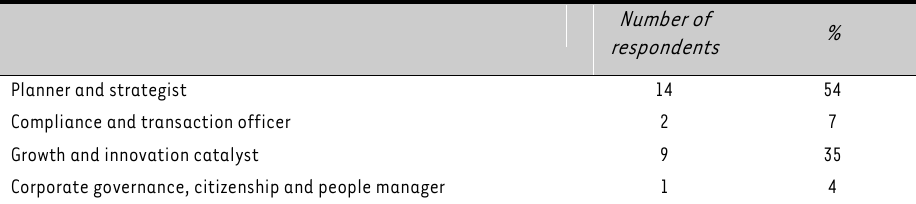
Number of % respondents